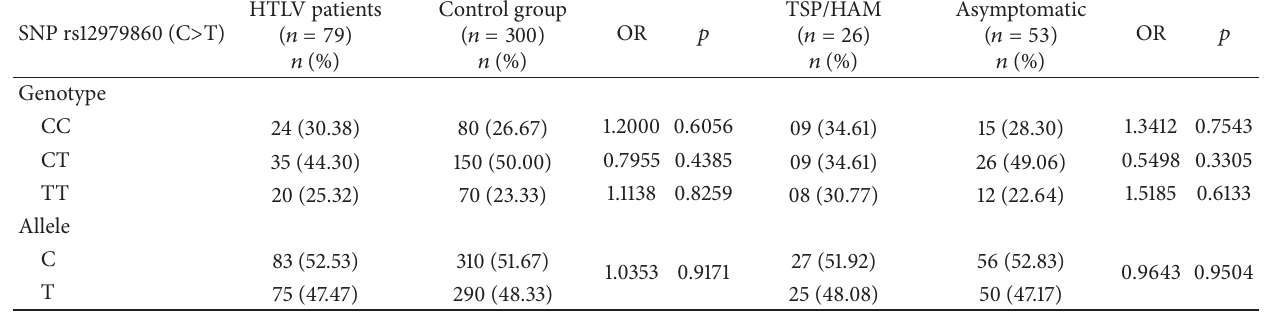
Table 1: Genotypic and allelic frequencies of the SNP rs12979860 in HTLV-1-infected patients and healthy control subjects.